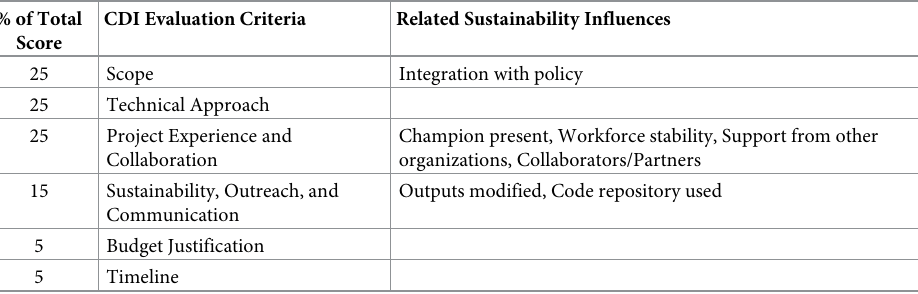
Table 7. Comparison chart of CDI proposal evaluation criteria and sustainability